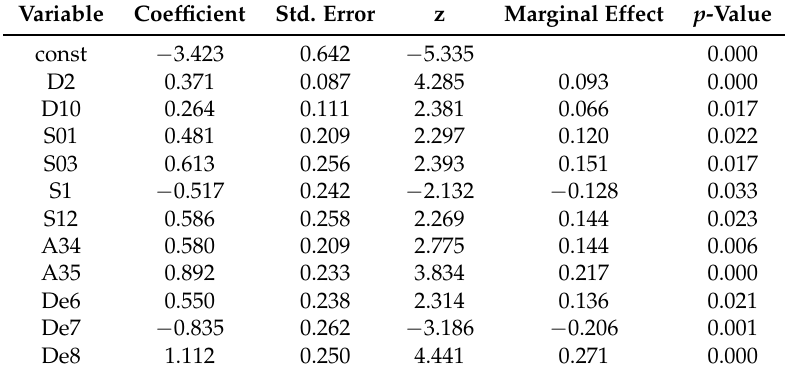
Table 8. Results of the final Logit regression model for dependent variable: K1 (standard errors based on Hessian) for determination of Y i .